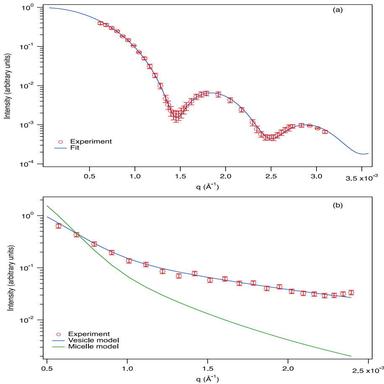
Results of typical static light scattering experiments for polymer particles (a) PMMA particles suspended in dodecane. The fit (blue line) is an RGD fit for a radius of 309 nm with a Gaussian distribution with a polydispersity of 6.6 % (after). (b) Cross-linked copolymer vesicles. The lines are best fits assuming a solid sphere (micelle) model (green) and a hollow sphere (vesicle) model (blue). The radius is 298 nm and polydispersity 32 % in both cases. For the vesicle model the shell thicknes